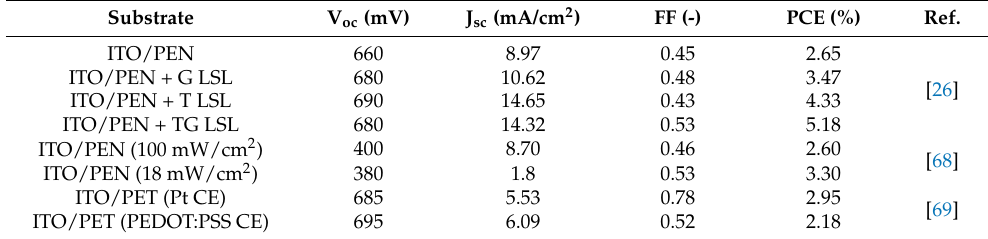
Table 1. Photovoltaic parameters of flexible dye-sensitized solar cells, containing dye N719. Substrate